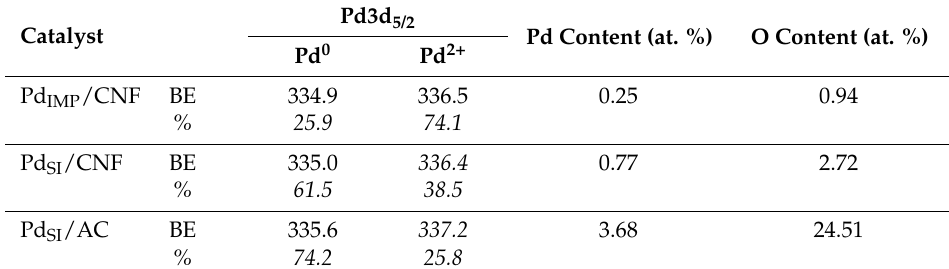
Table 1. Palladium, Oxygen atomic contents, and Pd oxidation state on the surface from XPS analysis.